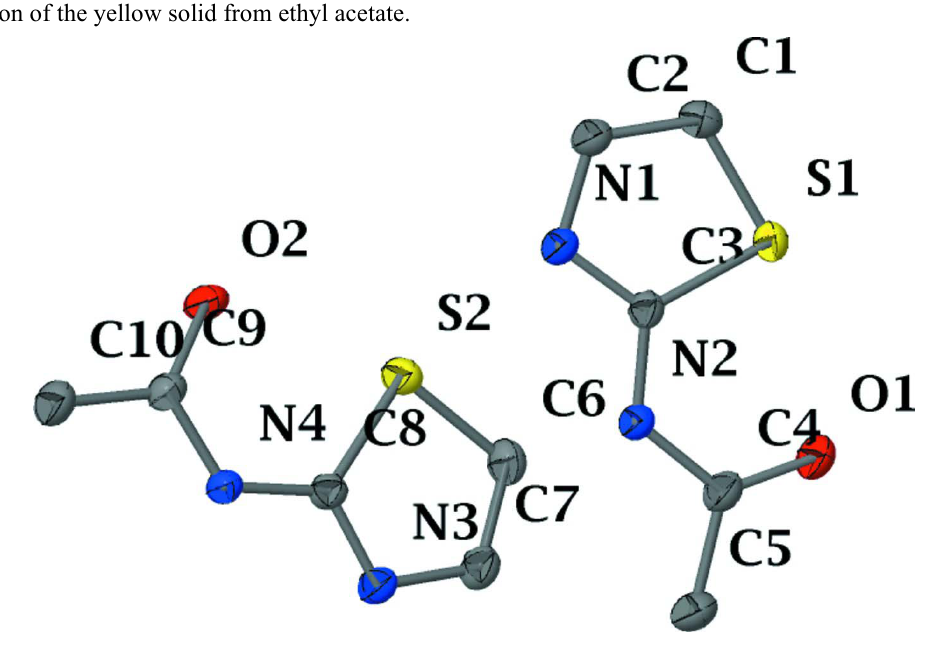
The molecular structure of (I) with ellipsoids drawn at the 50% probability